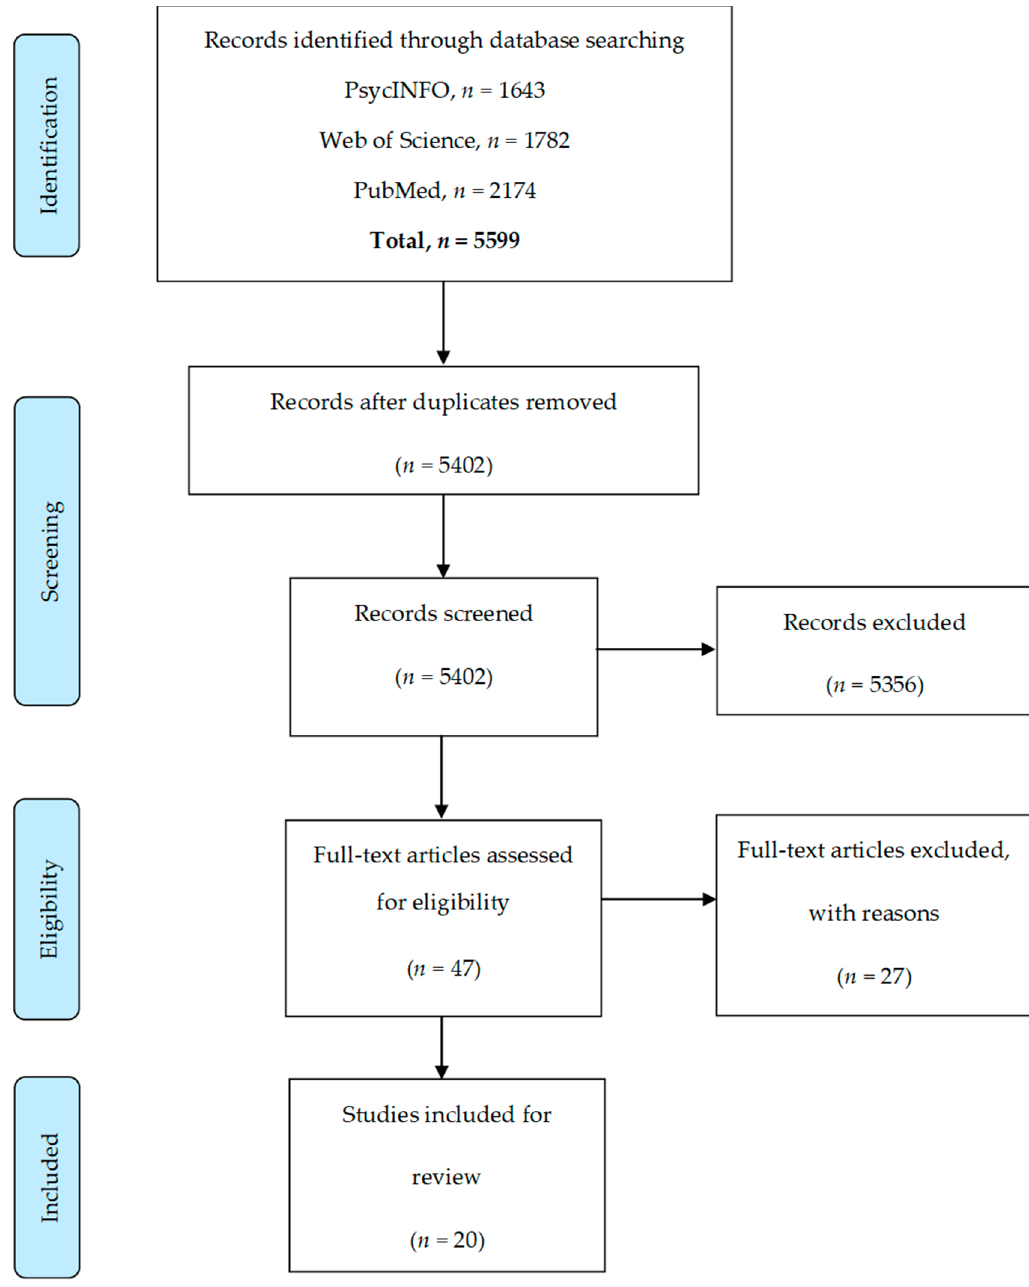
Figure 1. PRISMA Figure 1. PRISMA Flowchart.